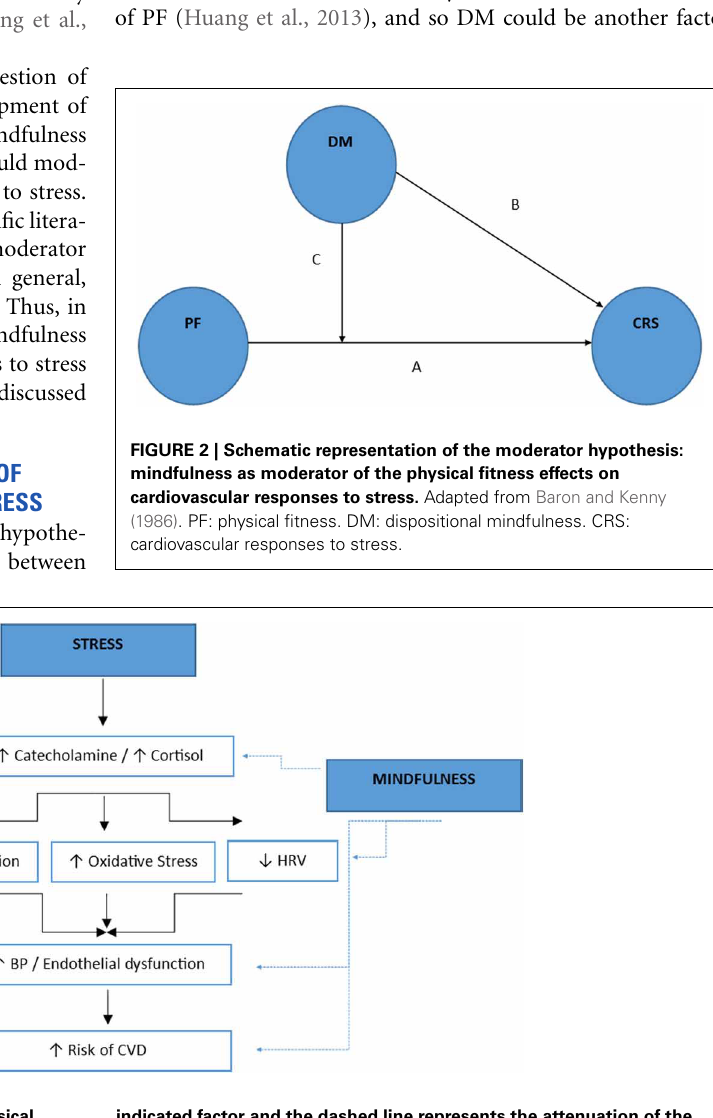
indicated factor and the dashed line represents the attenuation of the indicated factors). Adapted from Huang et al. (2013). HRV: heart rate variability. BP: blood pressure. CVD: cardiovascular